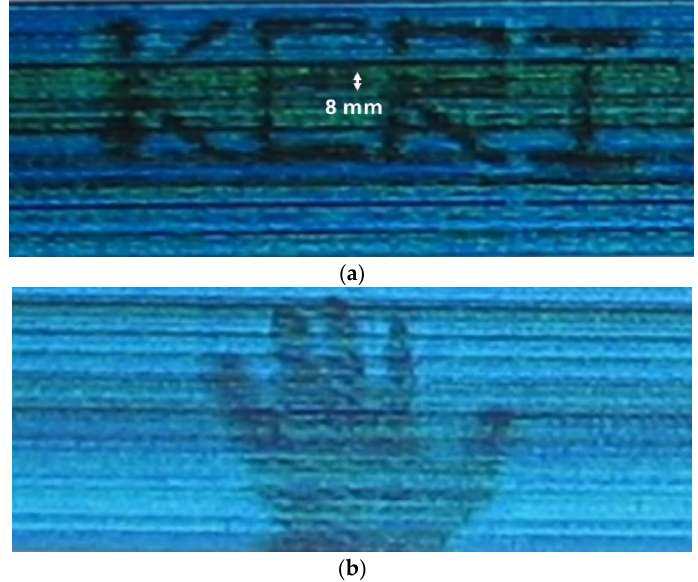
Figure 8. Captured image of the real-time THz video: ( a ) The institution logo, KERI (Korea Electrotechnology Research Institute); ( b ) A hand. Samples move horizontally with the scan speed of approximately 10 cm/s over the detector array. The image resolution less than 8 mm is verified from the measurement results because the measured images can discriminate the minimum line width of 8 mm marked in (a).